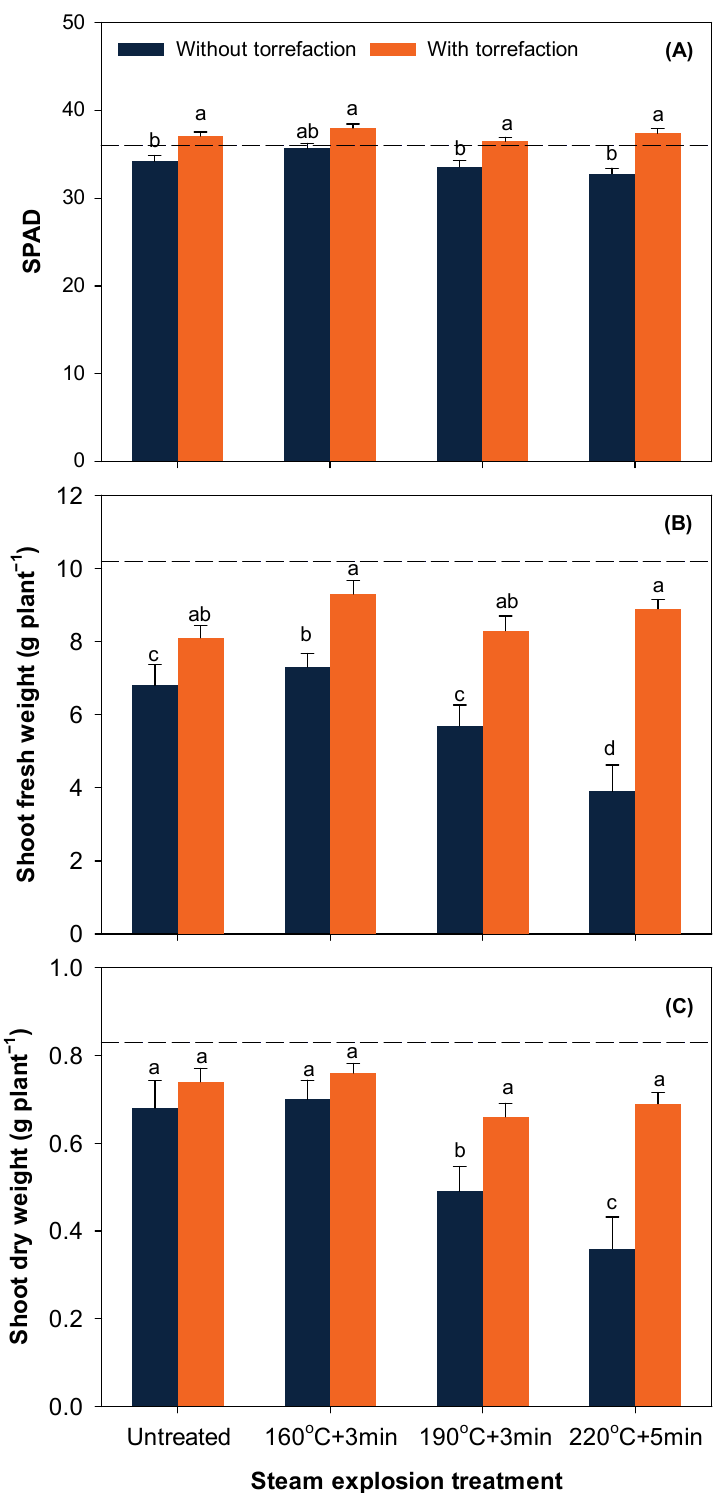
Figure 3. SPAD ( A ), shoot fresh weight ( B ), and shoot dry weight ( C ) of bok choy at harvest as affected by treatment × torrefaction interaction. The horizontal dash line represents bok choy grown in 100% commercial peat. Data represent mean ± SE. For each figure, means followed by different lower-case letters indicate significant difference at α =